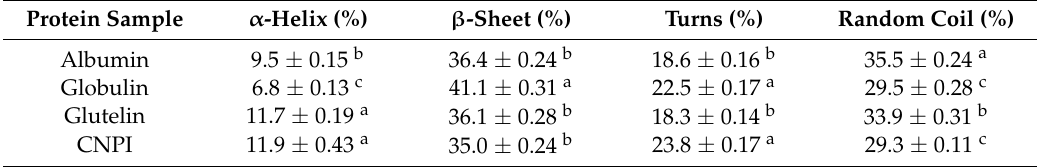
Table 3. Secondary structure composition of albumin, globulin, glutelin and CNPI from cashew nut. Protein Sample